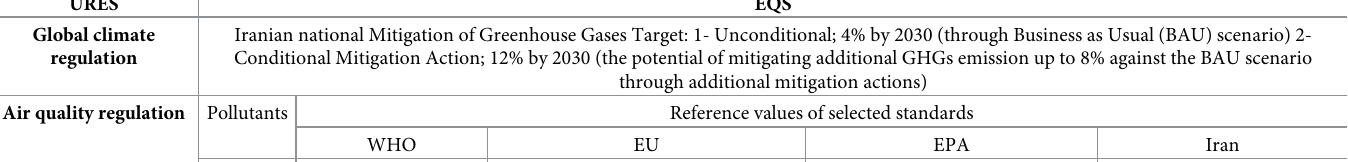
Table 1. Selected environmental quality standards (EQS) for assessing the matches and mismatches between urban regulating ecosystem services (URES) supply and demand.